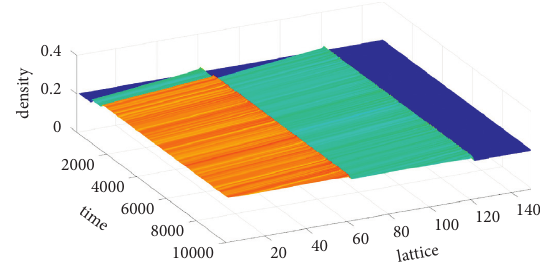
Figure 12: Spatiotemporal evolution pattern.